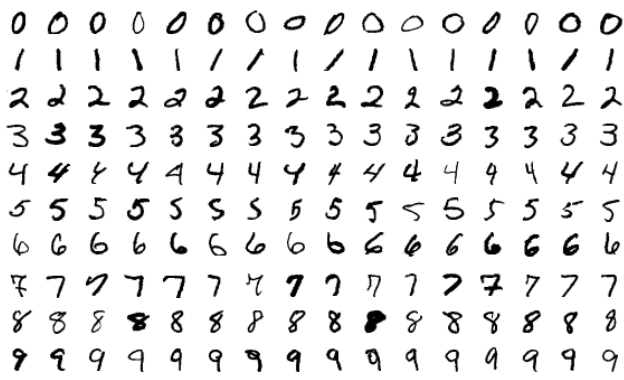
Figure 1. Examples of MNIST